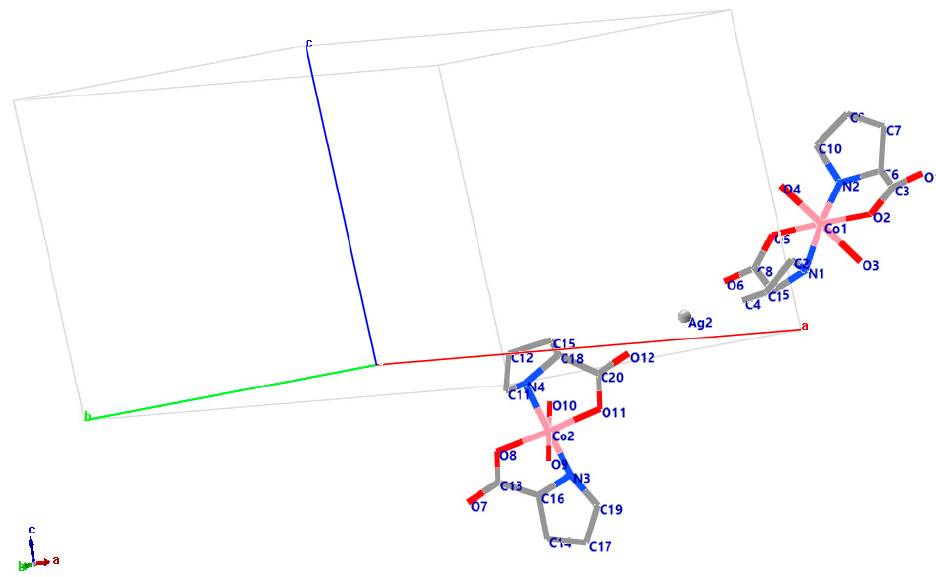
Figure 8. Crystal structure of PCC, interstitial Ag 0 NPs. Figure 9 demonstrated the refined pXRD of PCCAg 0 NPs.